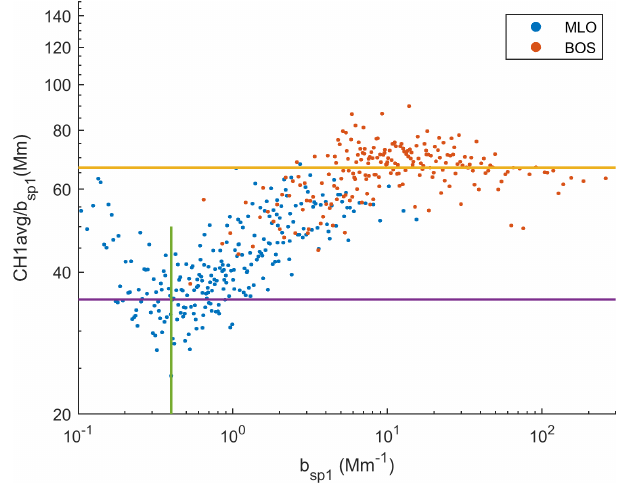
Figure 12. Ratios of CH1avg and measured scattering, b sp1 , as a function of measured b sp1 for MLO and BOS. The green line cor- responds to 0.4Mm − 1 , while the purple line, a ratio of 35Mm, cor- responds to the additive uncertainty of 14. The yellow line corre- sponds to a CH1avg /b sp1 ratio of approximately 67Mm, the slope of CH1avg vs. b sp1 above about 5Mm − 1 . Table 3. Ordinary least squares regression coefficients with a zero intercept and standard error for b sp1 and CH1 as the dependent and independent variables, respectively, for the BOS, MLO, and com- bined datasets. CH1 and b sp1 reported at STP. Also shown are the respective coefficients of determination, r 2